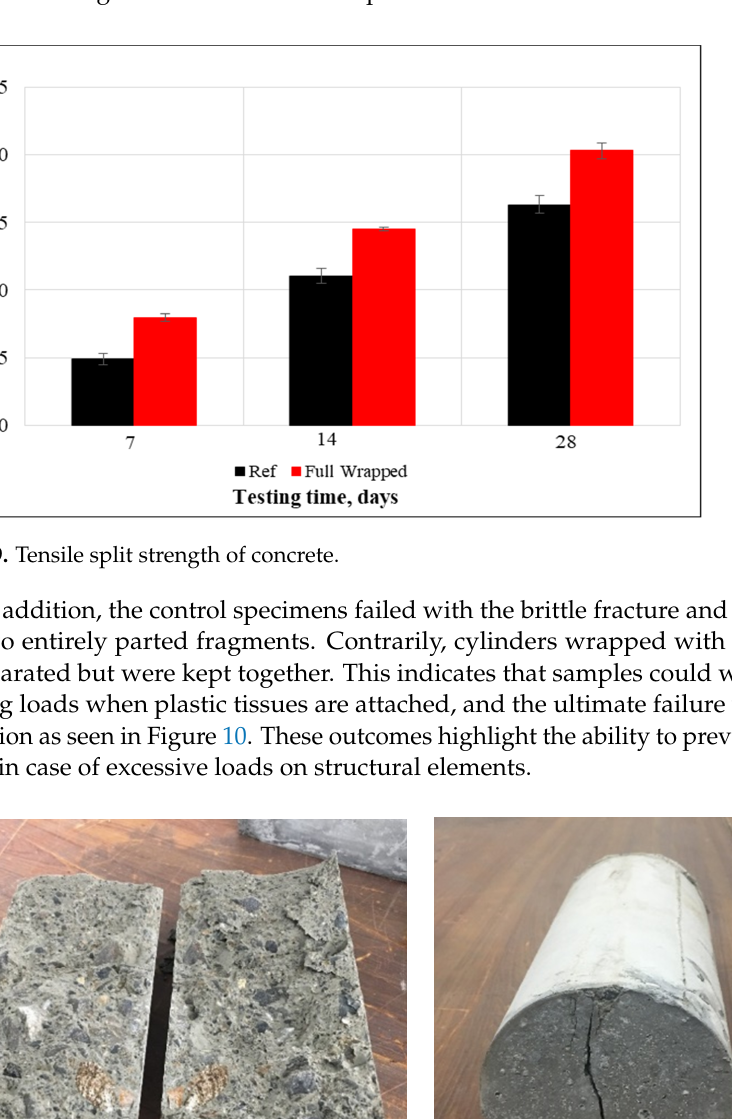
Figure 10. Failure mechanism of samples after split tensile strength. ( a ) Reference and ( b ) covered samples .